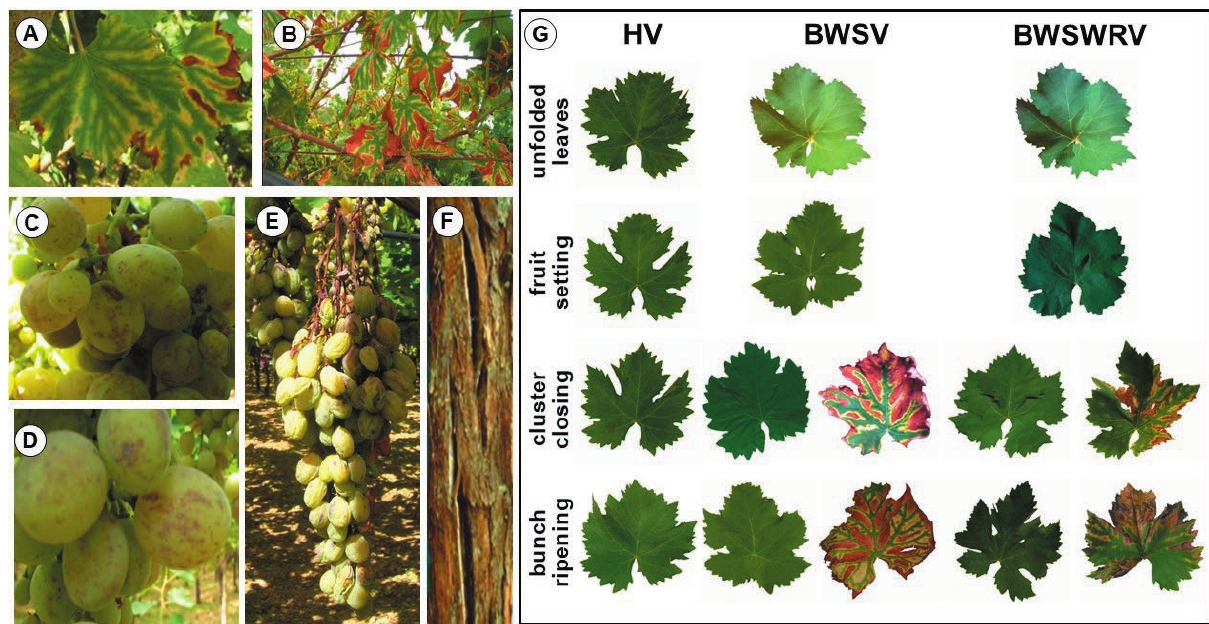
Figure 1. Symptoms developed in the 20-year-old Vitis vinifera ‘Italia’ vineyard. Chlorotic areas (A) and ‘tiger stripes’ (B) on leaves; spots on the skin (C-D) and wilt (E) of berries and cracking of the trunk (F) of the diseased vine. A selection of leaves (G) collected during the vine growth stages of unfolded leaves, fruit set, cluster closing and bunch ripening, from healthy vines (HV), vines with brown wood streaking (BWSV) or vines with brown wood streaking and white rot (BWSWRV).